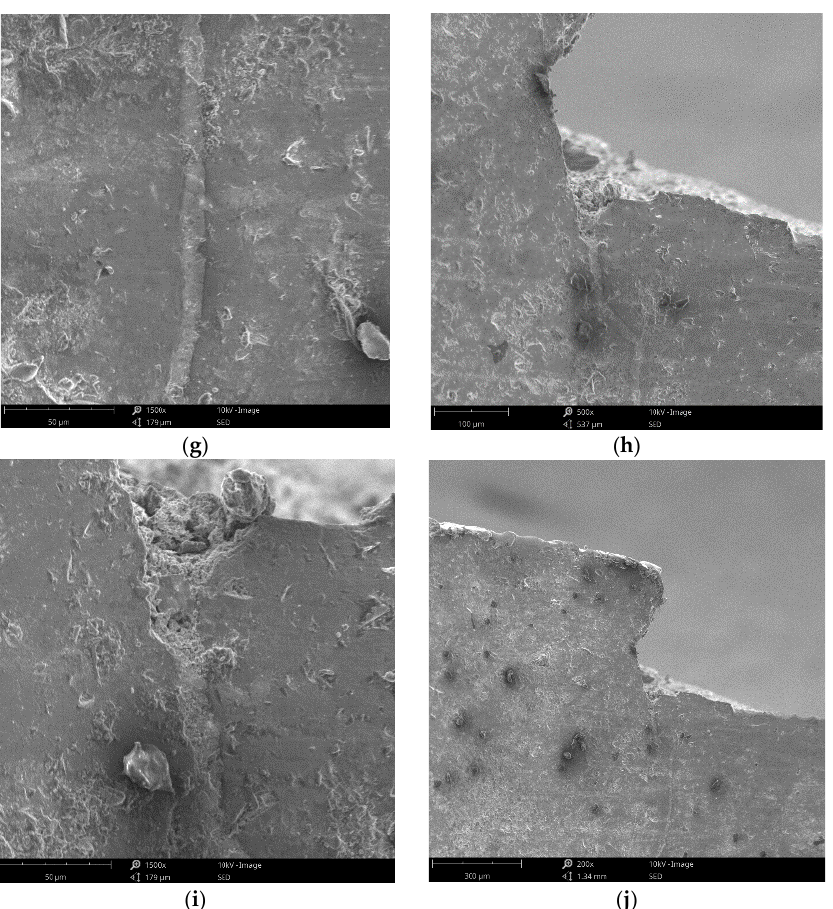
Figure 9. The examined area of the crack in the central part of the die: ( a ) pictorial view, ( b ) the examined area A, ( c – e ) pictures of the delamination area, ( f ) the examined area B, ( g , h ) notch and change in the plane of breaking crack, and ( i , j ) chipping of material in the notch area.